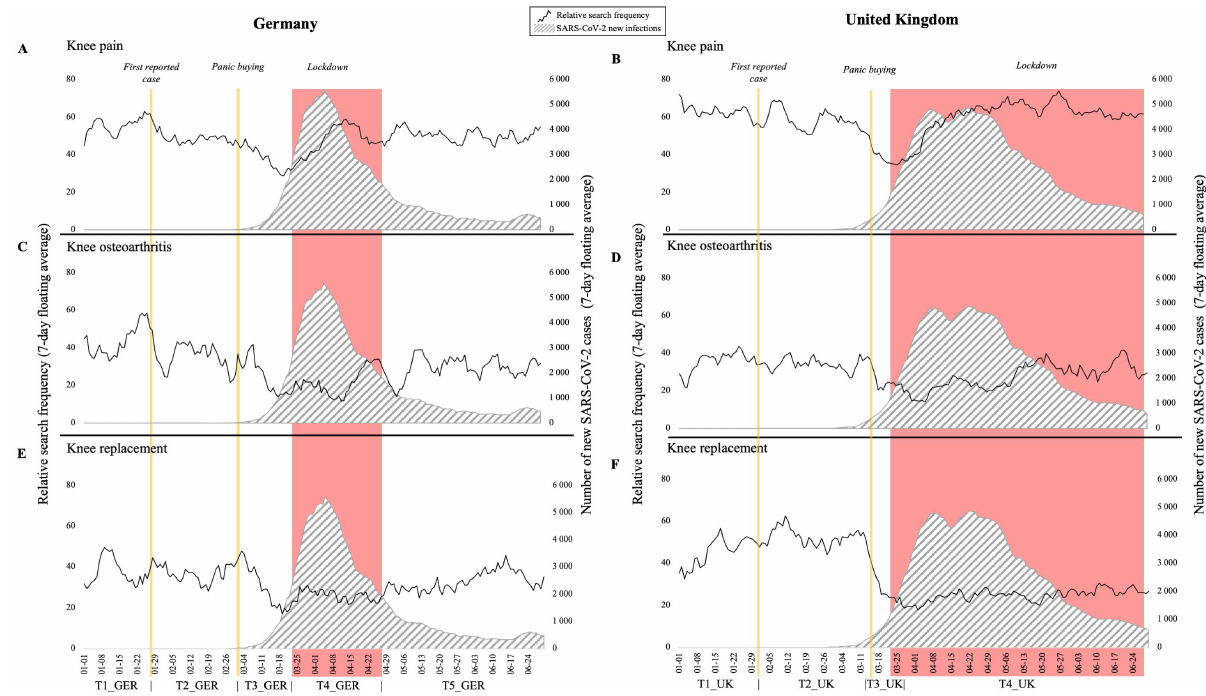
Figure 1. Public interest as relative search frequencies (black curve) of ( A , B ) knee pain, ( C , D ) knee osteoarthritis, and ( E , F ) knee prosthesis and number of new SARS-CoV-2 infections (grey, striped area) in the first half of 2020 in Germany and the UK, respectively. Relevant events and time frames are highlighted in color.